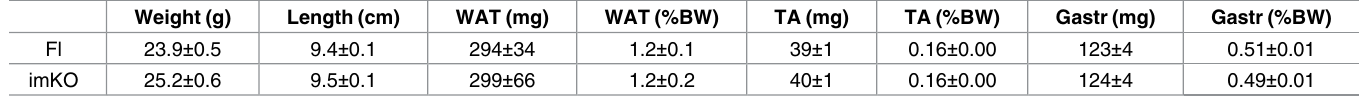
Table 1. Characteristics of imKO mice. Weight